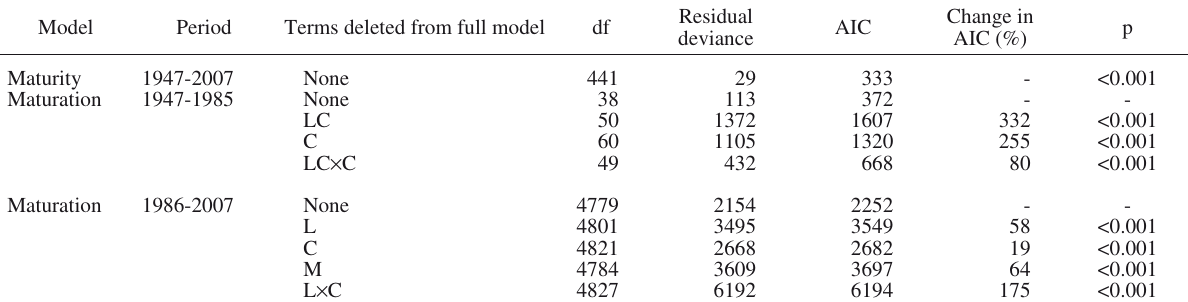
Table 1. – Properties of the models fitted to sardine maturity and maturation of FYS in 1947-2007. LC, length class; C, cohort; M, month. The first line for each period describes the final model. Subsequent lines correspond to simplified models by deleting terms involving a given predictor (e.g. LC terms deleted indicates both LC and LC × C terms have been deleted). The change in AIC is relative to the final